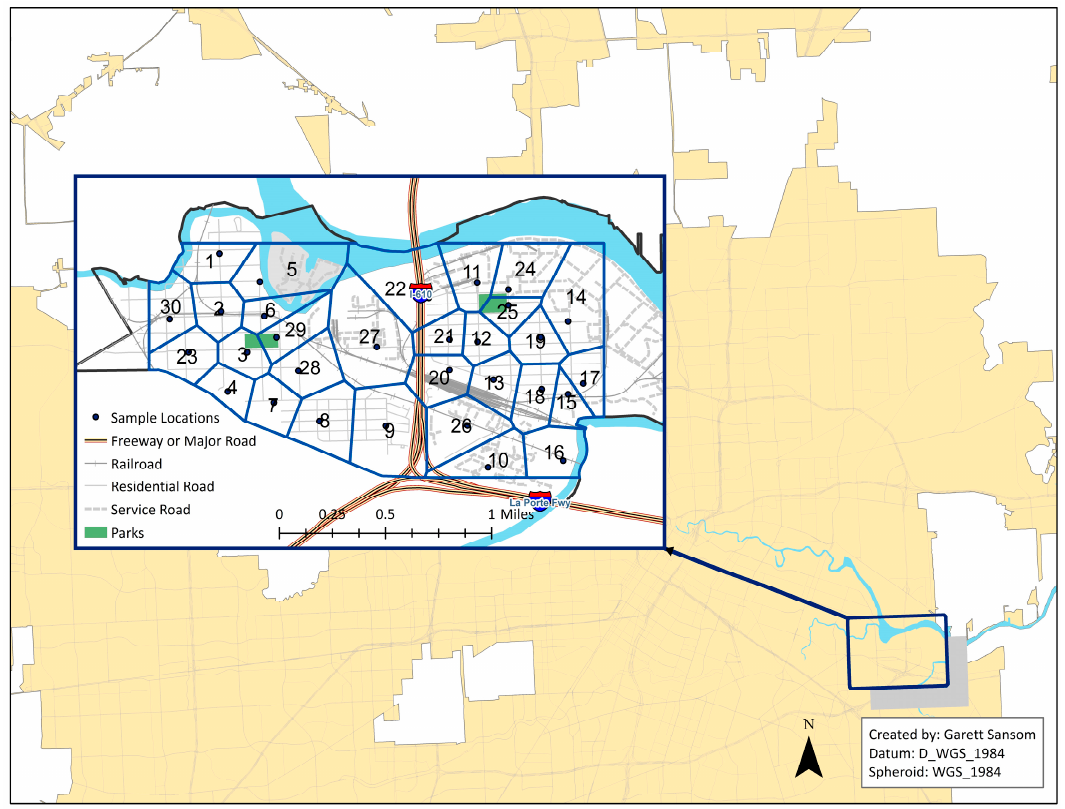
Figure 1. Water sampling locations within Thiessen polygon zones.